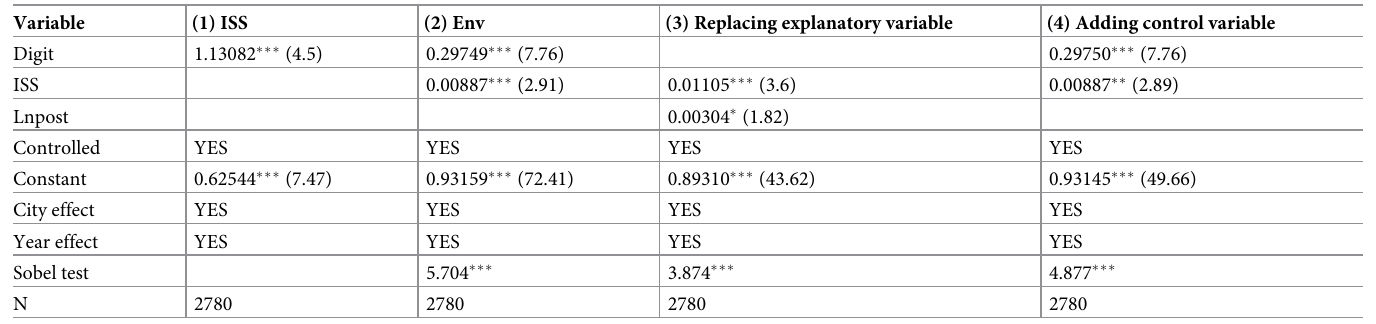
Table 7. Results of the mediation and robustness tests. Variable